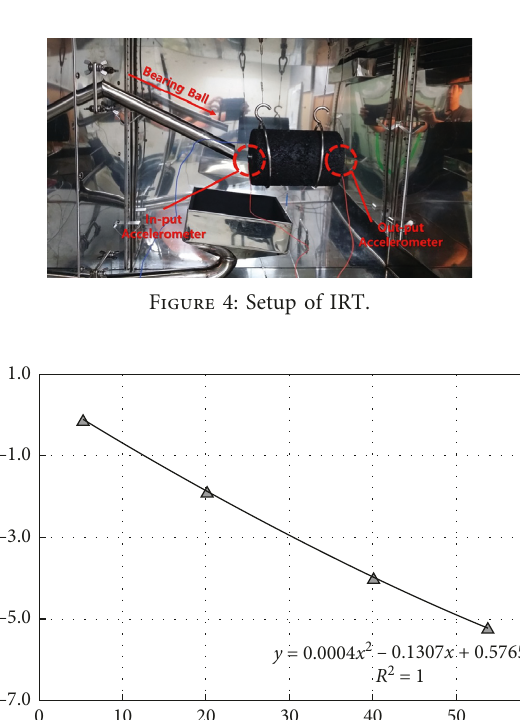
Figure 3: The testing machine of